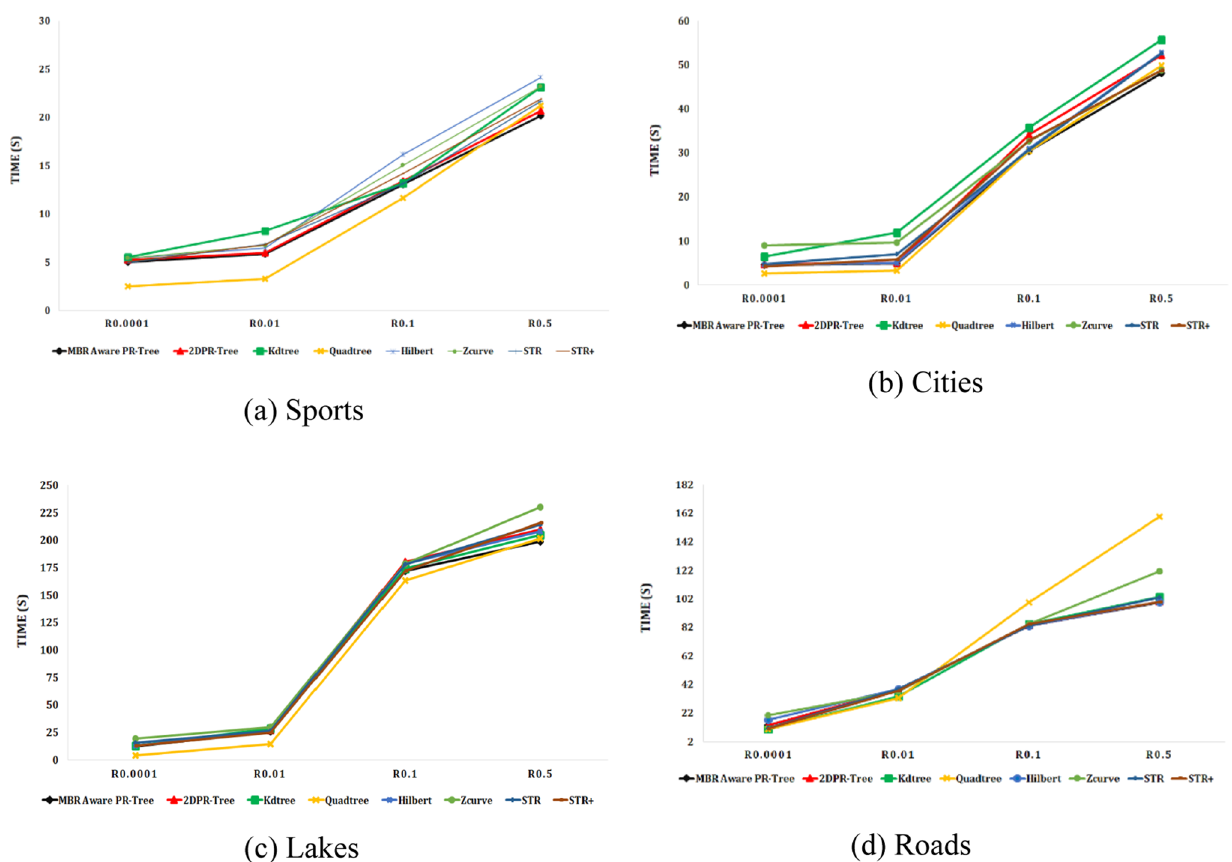
Fig. 11 Range query execution time with for query window area 0.01%, 1%, 10%, and 50% on indexed real datasets a Sports, b Cities, c Lakes, and d Roads